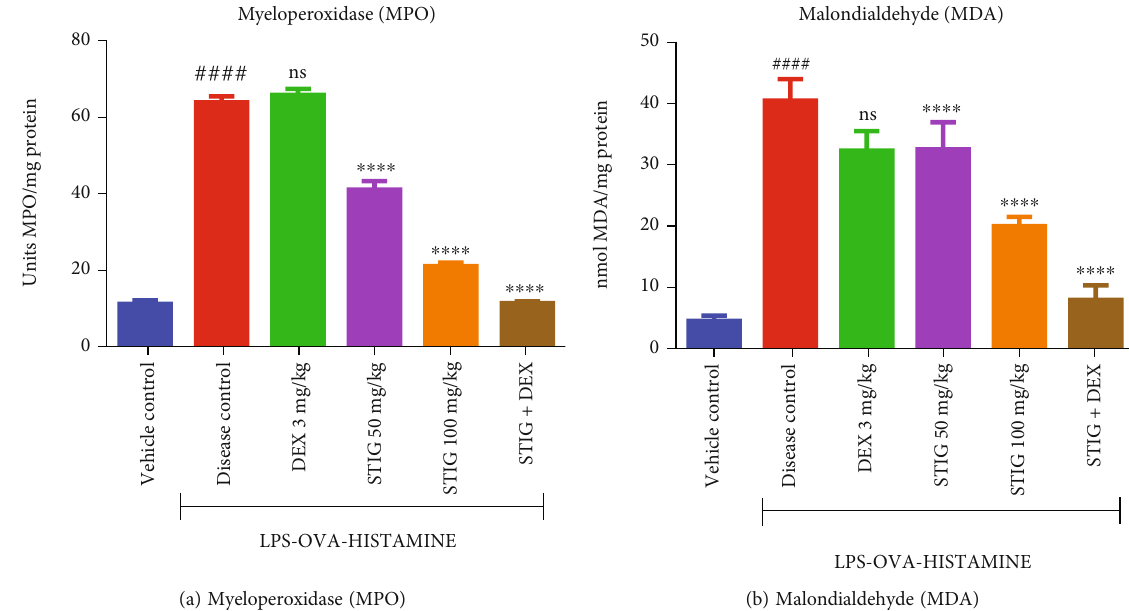
Figure 3: E ff ect of STIG and STIG+DEX on MDA and MPO levels. Data is expressed as mean ± SEM . #### p < 0 : 0001 compared to the vehicle control group; ∗∗∗∗ p < 0 : 0001 and ns (not signi fi cant) as compared to the disease control group using one-way ANOVA followed by Dunnett ’ s post hoc